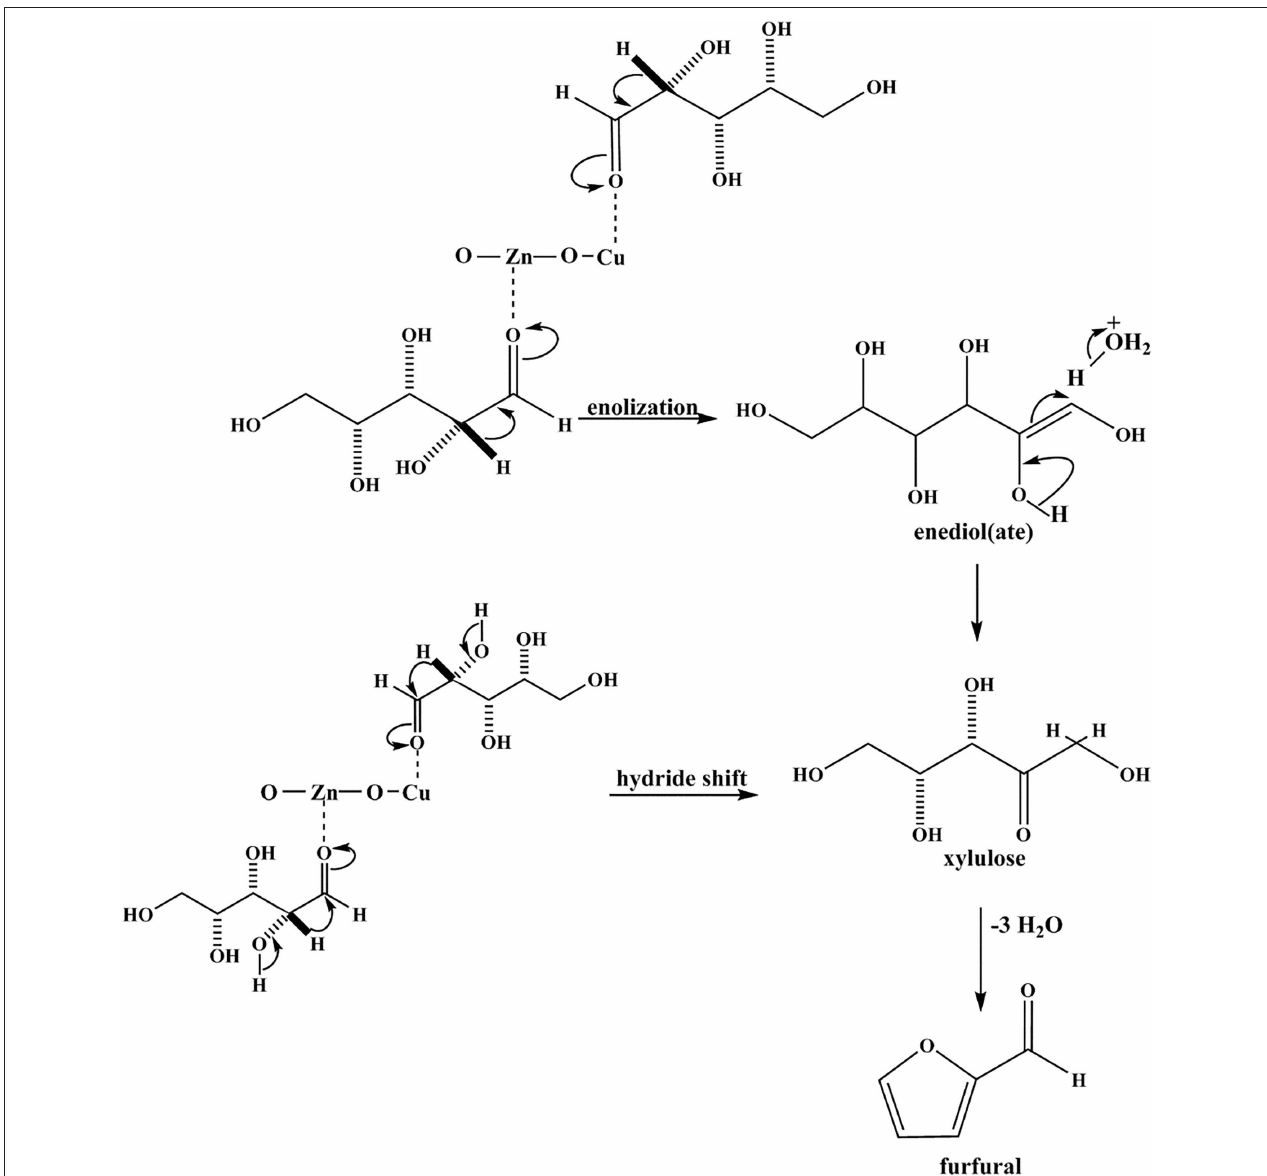
FIGURE 2 | Possible reaction mechanism for the dehydration of xylose to furfural on Zn doped CuO catalyst. Reprinted from Mishra et al. (2019), with permission from